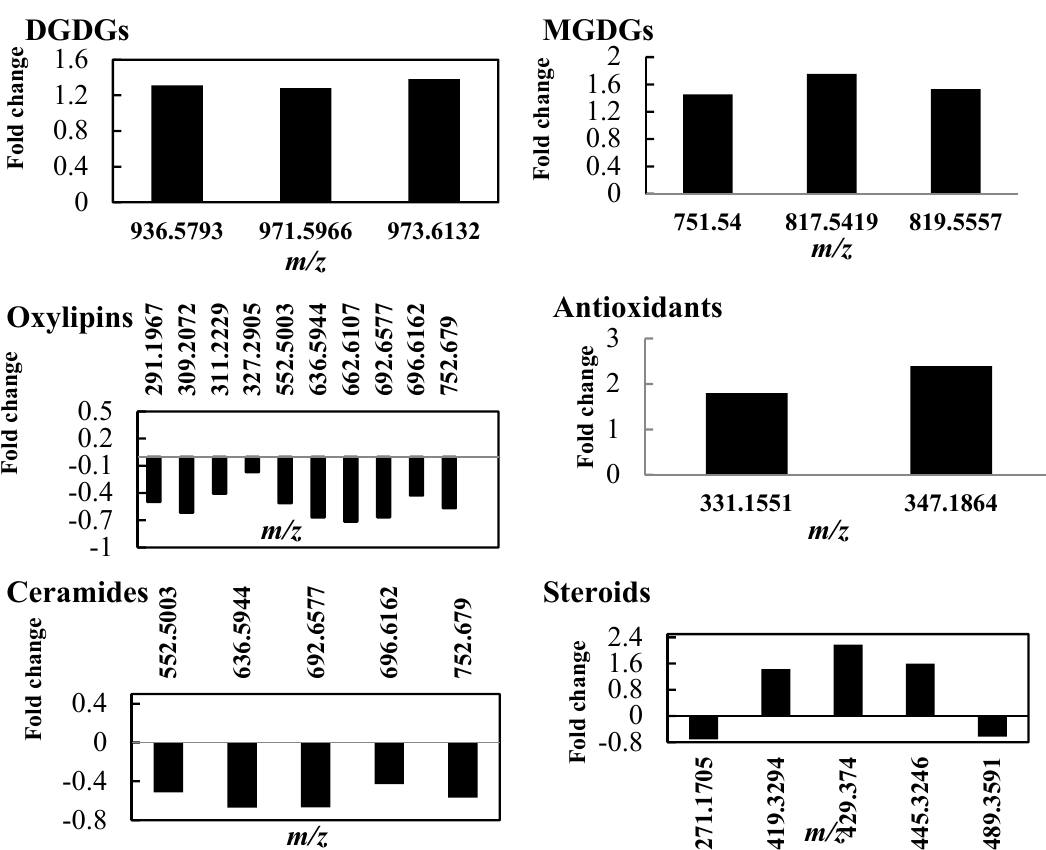
Figure 3. Lipid composition changes in tolerant thyme plants under drought conditions. After withholding water, thyme leaves were harvested and non-polar extracts were analyzed by DI FT-ICR mass spectrometry. The vertical axis represents the fold change between the control and stressed plants. The mass-to-charge ( m/z ) values are reported next to each bar (abbreviations: PI, phosphatidylinositol; PS, phosphatidylserine; PC, phosphatidylcholin; DGDGs, digalactosyldiacylglycerols; MGDGs, monogalactosyldiacylglycerols).